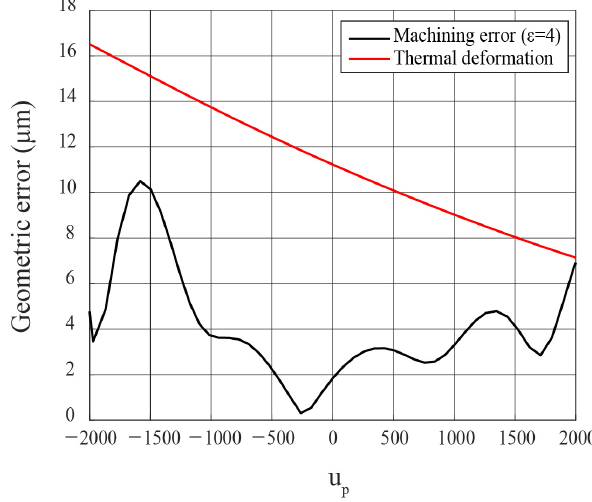
Figure 6. Geometric error induced from the machining error (black) and from thermal deformation (red), respectively, when a plastic gear operates at 200 RPM under 20 Nm. The parameters for machining error and thermal uncertainties are set as (cid:101) = 4 and η = 0, respectively. It shows that thermal deformation can lead to higher geometric error than machining error in the case of a plastic gear, which is unlikely to happen in steel